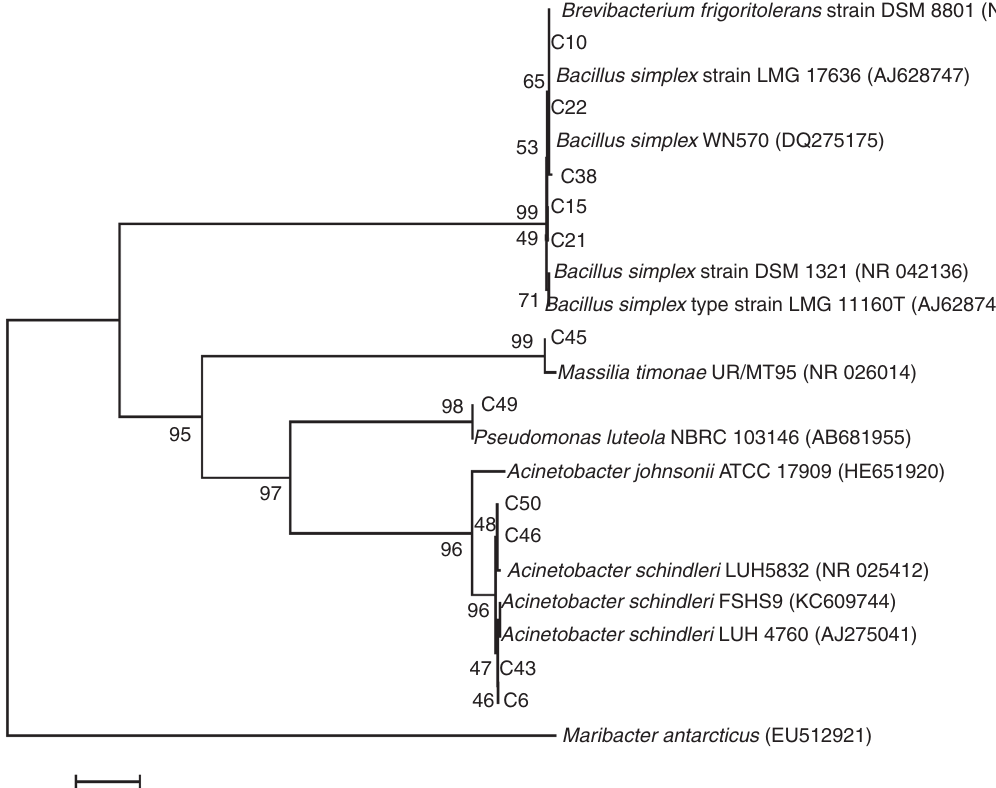
Fig. 2 Phylogenetic tree of the bacterial community isolated from decayed calcarenite stones in San Jeronimo Monastery. The phylogenetic tree shows the taxonomic location of a representative strain from each REP-PCR group based on 16S rRNA sequences. Reference strains are also indicated. The signi fi cance of each branch is indicated by bootstrap values calculated for 1000 subsets. Scale bar : two nucleotides substitutions per 100